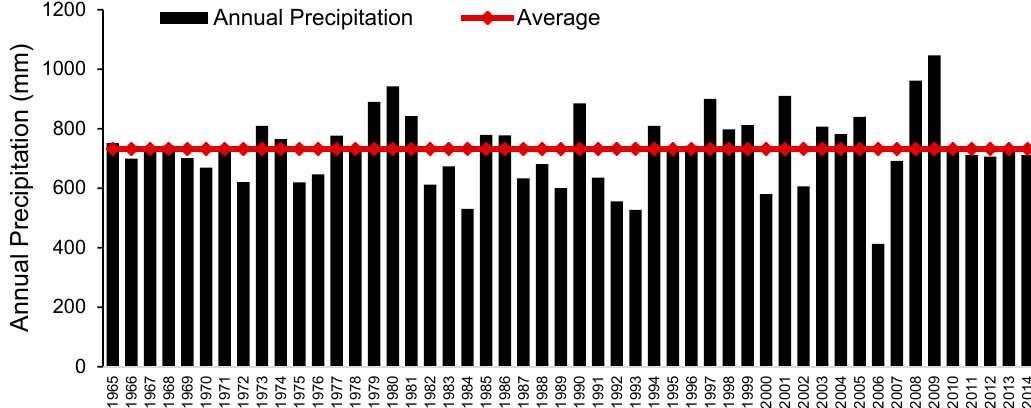
Figure 6. Annual precipitation of Istanbul including severe dry and wet periods for the city in the last 50 years.